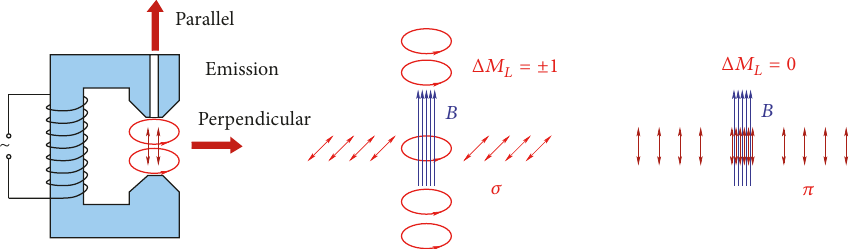
Figure 10: Scheme of observation of the Na-D-line in a strong magnetic